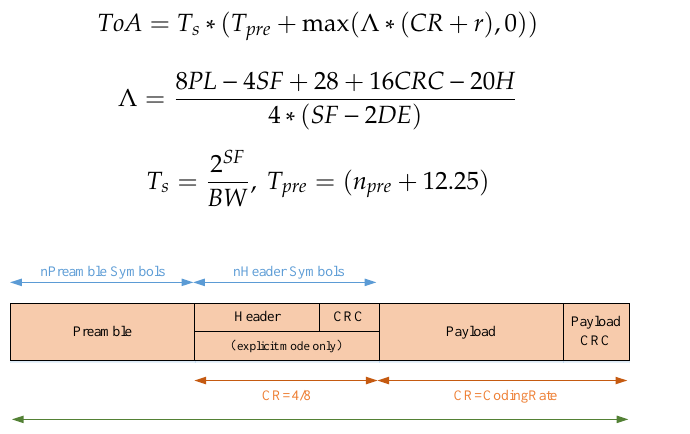
Figure 7. Packet structure of LoRa.